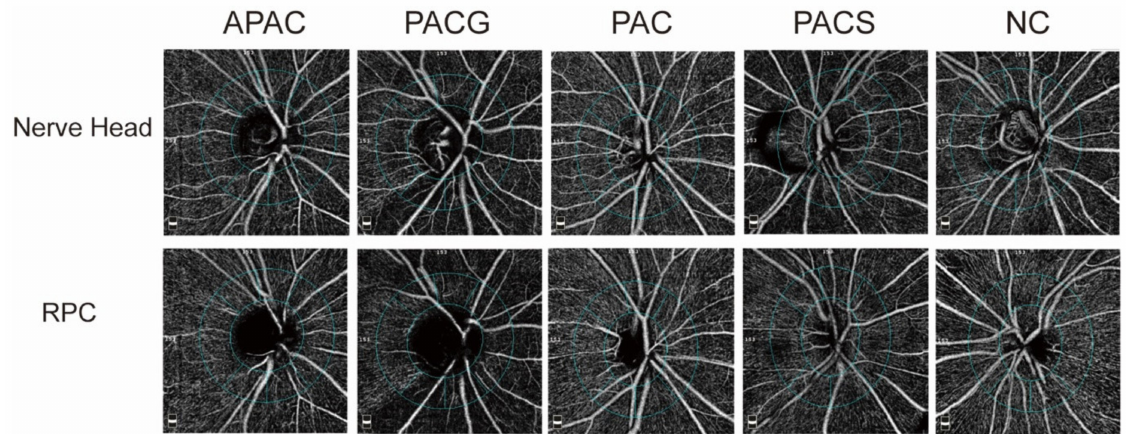
Figure 1. Image of vessel density (VD) in the nerve head layer and radial peripapillary capillary (RPC) layer. The vessel densities of peripapillary sectors are calculated over a 0.75 mm-wide elliptical annu- lus extending from the optic disc boundary. APAC = acute primary angle-closure; PACG = primary angle-closure glaucoma; PAC = primary angle-closure; PACS = primary angle-closure suspect; NC = normal